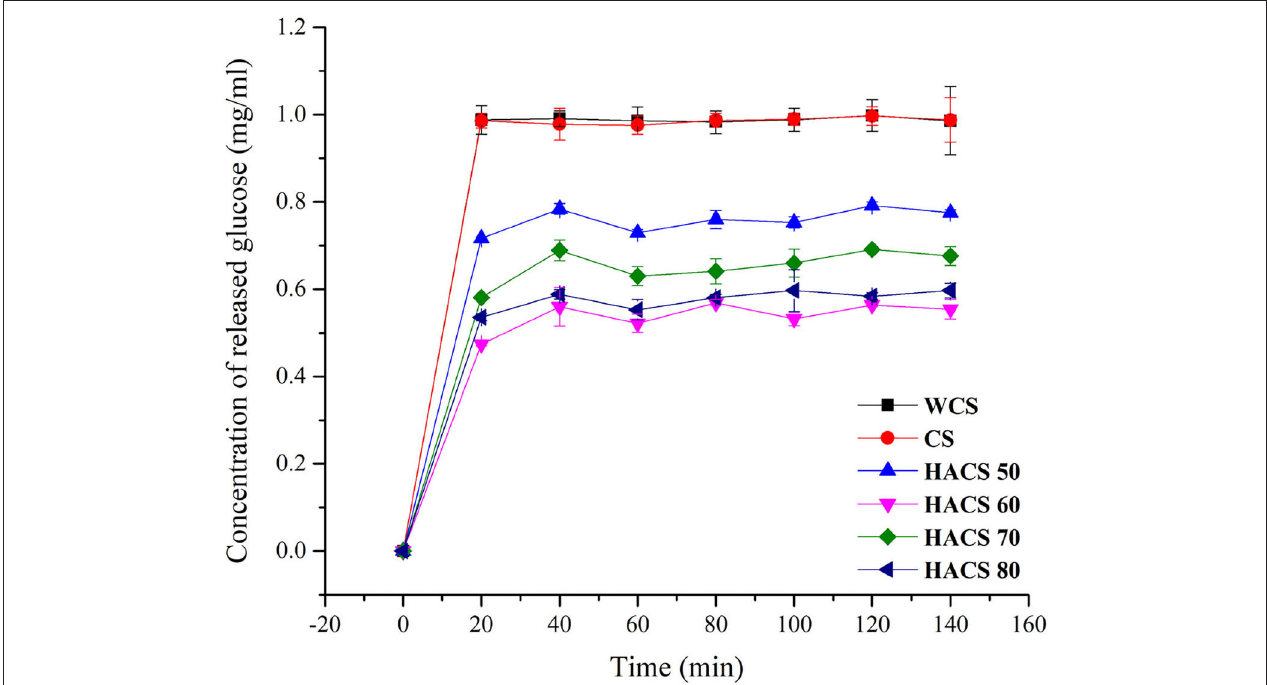
FIGURE 1 | In vitro digestibility of corn starch with different amylose